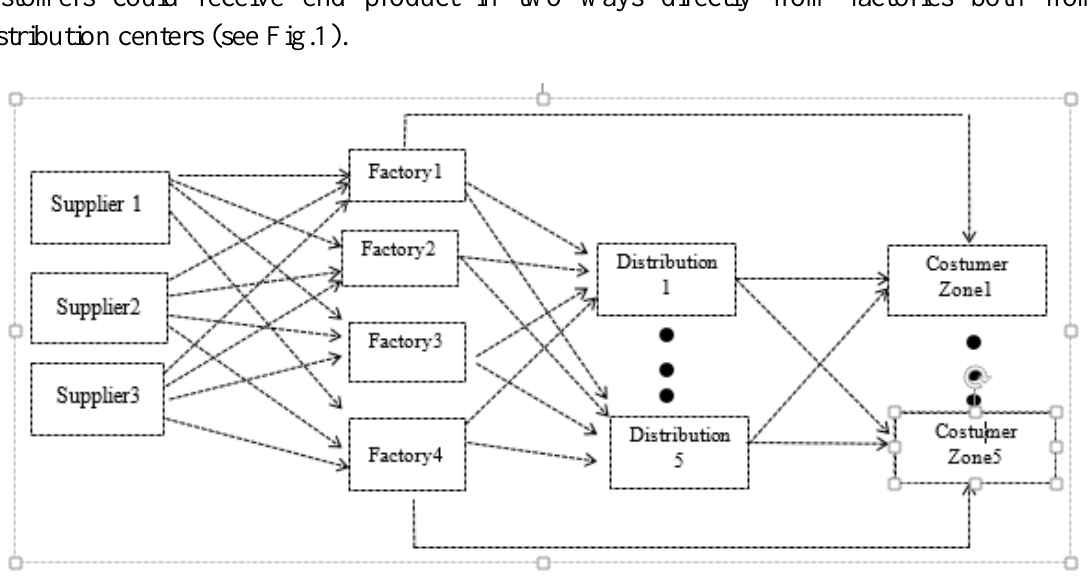
Fig1 . Schematic example supply